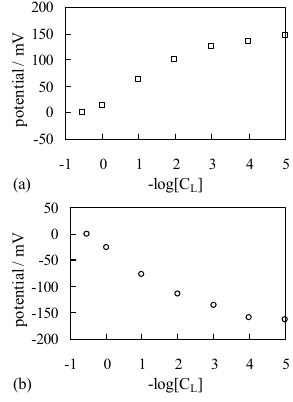
Figure 5. Membrane potential generated across ( a ) SMG90 and ( b ) CMG90 against –log[C L ].